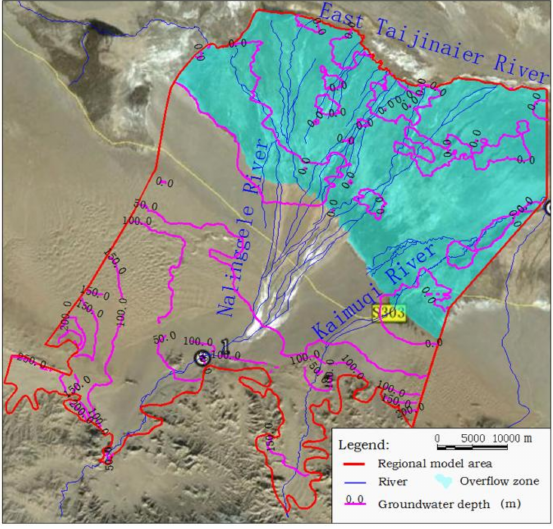
Figure 10. Map of groundwater depth contour and overflow zone during the calibration